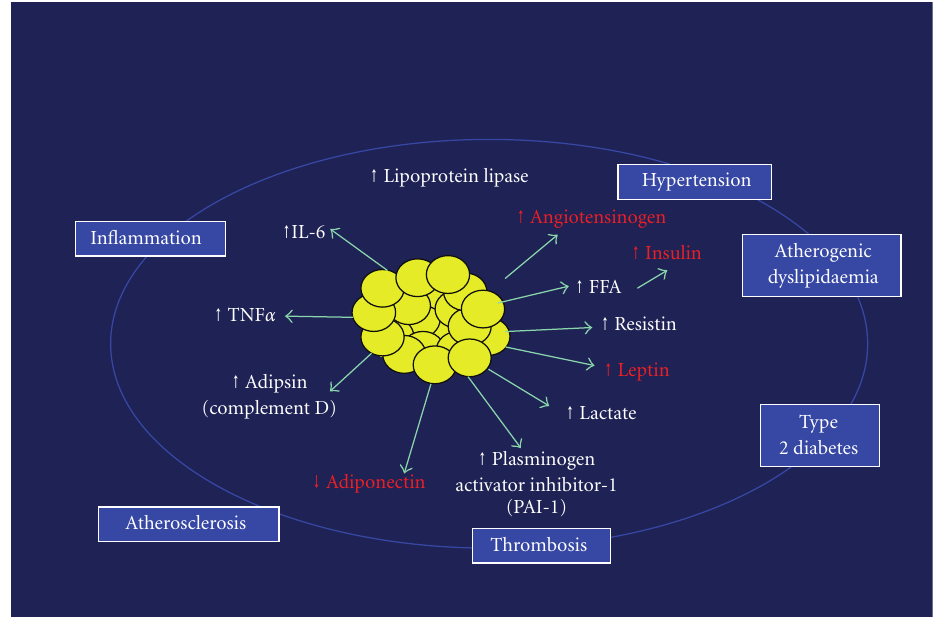
Figure 1: Adverse cardiometabolic e ff ects of products of adipocytes (from Scaglione et al. ([12]